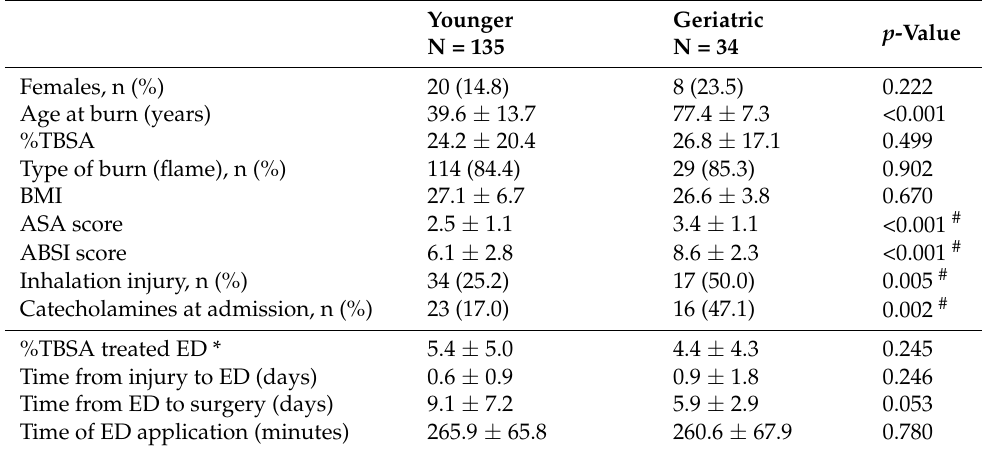
Table 1. Patient demographics and treatment characteristics.